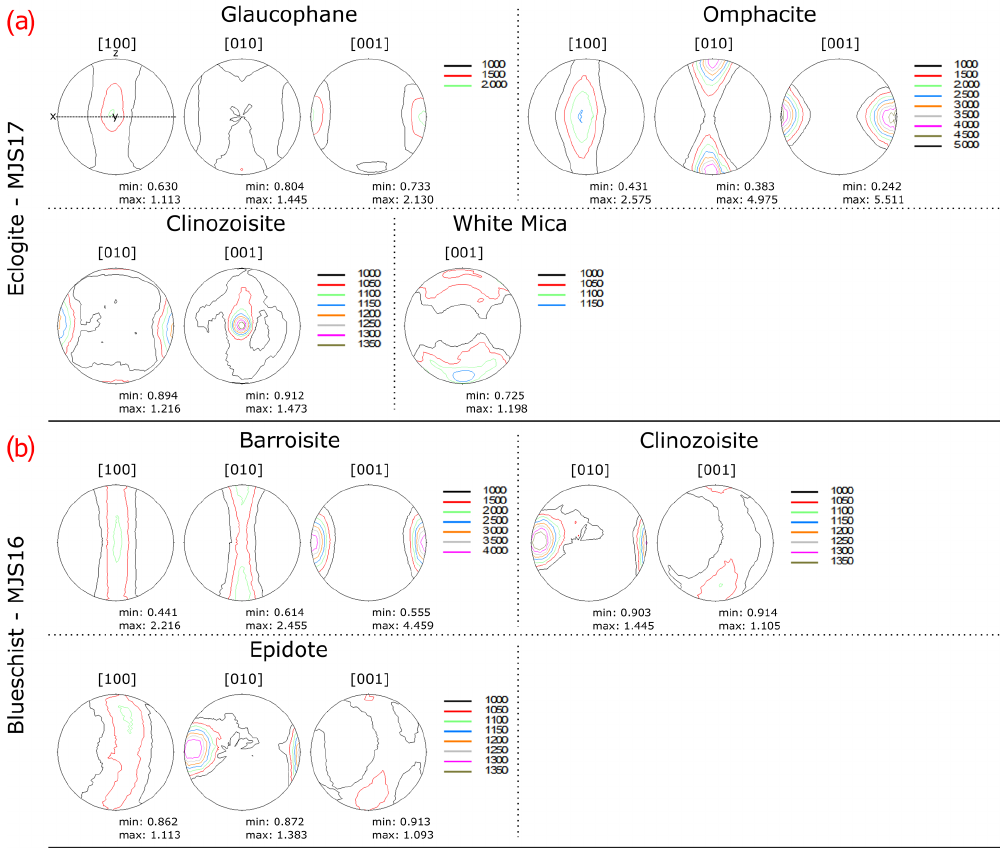
Figure 4. Calculated pole figures of important mineral phases in the eclogite ( a ; MJS17) and the blueschist ( b ; MJS16). The stretching lineation (kinematic x direction) is oriented EW in the pole figures, the foliation normal (kinematic z direction) is oriented NS and the kinematic y direction (perpendicular to x and z directions) is normal to the pole figure plane. The pole figures are lower hemisphere equal area projections. The contour levels display multiples of random distribution and minimum and maximum values are listed below the pole